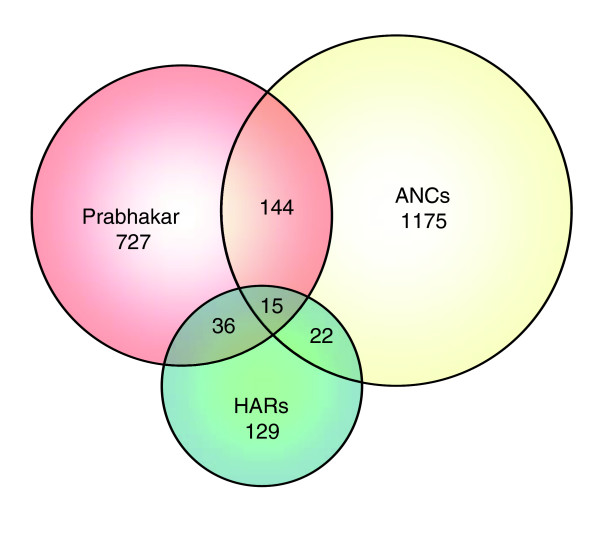
Venn diagram of overlap between accelerated sequences in the three studies. The figure shows the overlap between the present study (yellow), the study by Pollard and coworkers [18] (green), and the study by Prabhakar and colleagues [19] (pink). ANC, accelerated noncoding; HAR, human accelerated region.